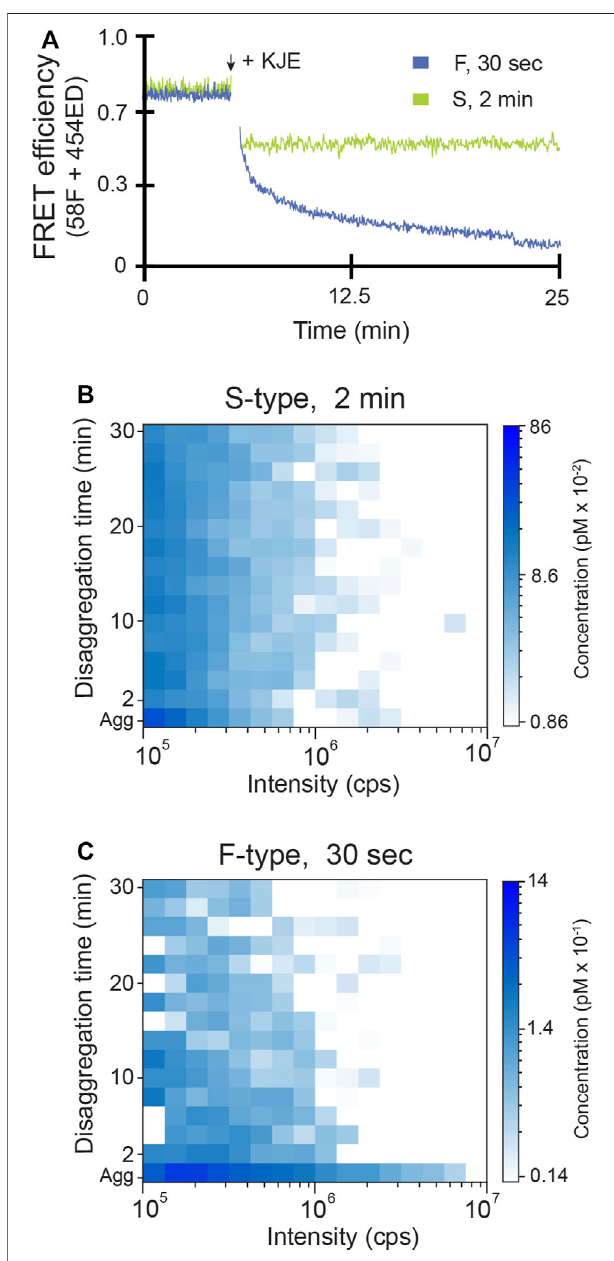
FIGURE 3 | F-type RuBisCO aggregates can be partially disassembled by the KJE system alone. (A) The disassembly of early-stage S-type (green) and F-type (blue) aggregates by the DnaK system (KJE) was examined by inter-molecular FRET. Co-labeled aggregates (1:1 mixture of 58F and 454ED monomers) formed at early time points (2 min for S-type and 30 s for F-type) were mixed with 0.5 µM DnaK, 1 µM DnaJ and 1 µM GrpE plus 2 mM ATP and an ATP regeneration system. The population-resolved kinetics of RuBisCO-TMR aggregate disassembly was examined by BAS for (B) S-type and (C) F-typeparticles,underthesameexperimental conditionsusedfor (A) . The aggregate particle distributions prior to the addition of KJE are shown ( Agg ). Following addition of KJE and ATP, aggregate disassembly was monitored in real time and BAS histograms were calculated for every 2 min